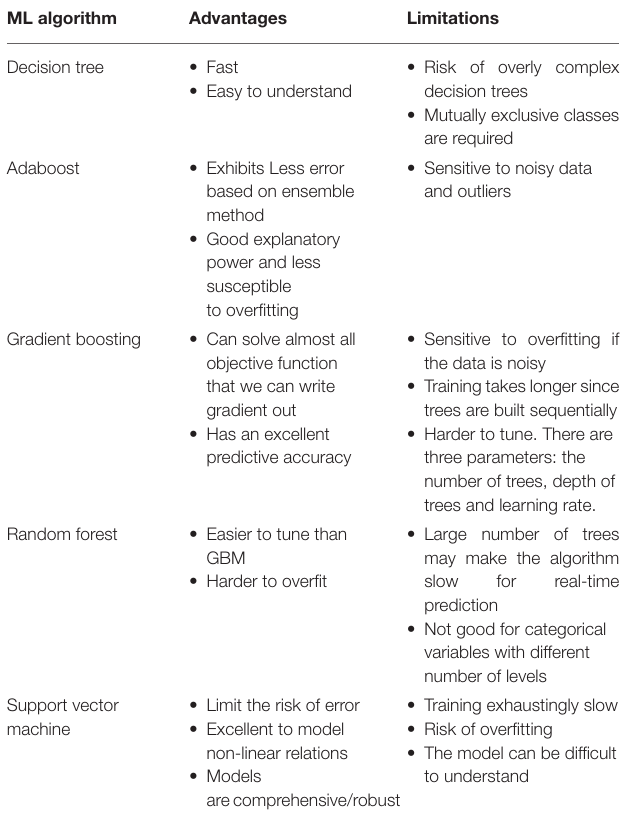
TABLE 4 | The advantages and limitations of the five selected machine learning algorithms. ML